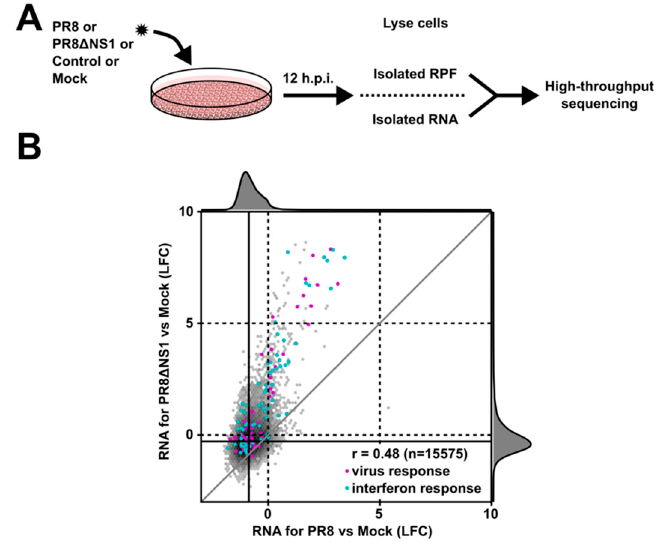
Figure 1. Identification of small open reading frame (smORF)-containing long noncoding RNAs (lncRNAs) differentially regulated upon infection. ( A ) Experimental scheme to identify novel micropeptides. A549 cells were infected with either influenza PR8 or PR8 Δ NS1. Twelve hours post infection, cells were collected, and ribosome-protected RNA (RPF) and total RNA was isolated and sequenced; ( B ) Comparison of log2 fold changes in PR8 and PR8 Δ NS1 infected cells compared to mock infection. Genes associated with virus and interferon response gene ontology (GO) terms are highlighted in purple and light blue, respectively. h.p.i.: hours post infection; LFC: log2 fold change.